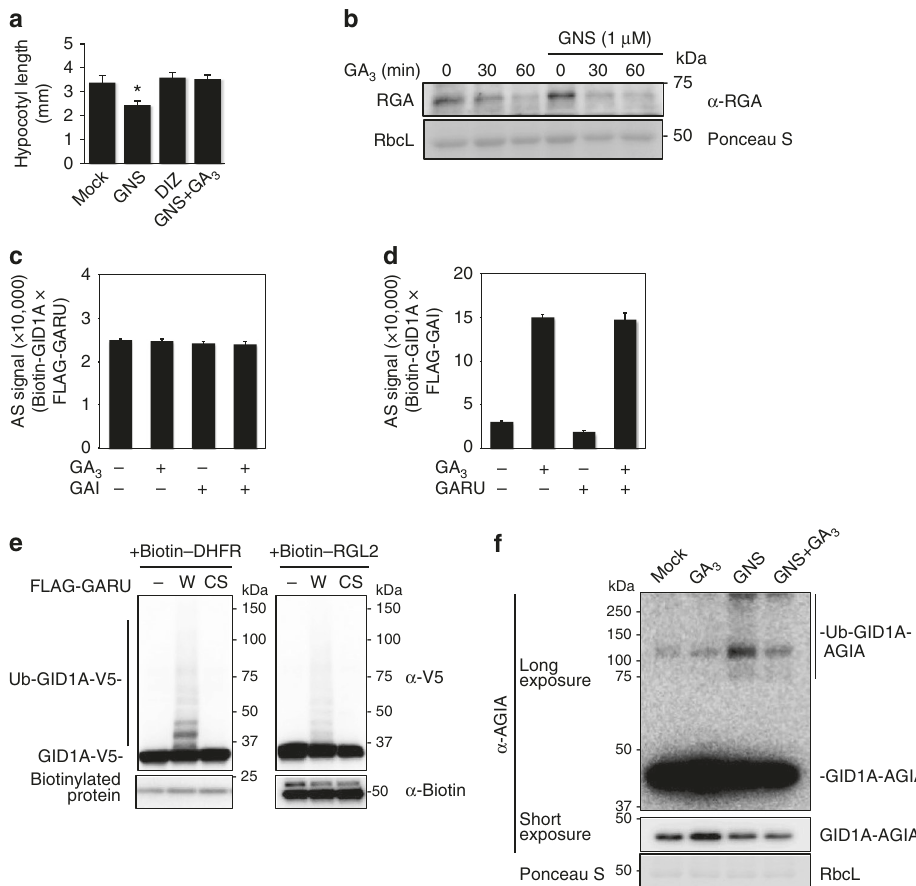
Fig. 5 GA blocks GARU-dependent GID1A ubiquitination. a Hypocotyl elongation assay of etiolated seedlings in response to 10 µ M GNS, 10 µ M daidzein (DIZ), and 10 µ M GNS with 5 µ M GA 3 (GNS + GA 3 ). Error bars indicate ± s.d. of three replicates, n = 21. Statistically signi fi cant changes compared with Mock are indicated ( *P < 0.05, as determined using two-tailed Student ’ s t -test). b GA-induced RGA degradation assay in Col-0 seedlings that were pretreated without or with 1 µ M GNS for 6 h. Seedlings were treated with 5 µ M GA 3 at indicated times. c AlphaScreen analysis of biotin – GID1A – FLAG – GARU interaction in the presence (+) or absence ( − ) of 1 µ M GA 3 and V5-GAI. Data are means ( ± s.d.) of three independent experiments ( n = 3). d AlphaScreen analysis of biotin – GID1A – FLAG – GAI interaction in the presence (+) or absence ( − ) of 1 µ M GA 3 and V5-GARU. Data are means ( ± s.d.) of three independent experiments ( n = 3). e In vitro ubiquitination assay of GID1A. GID1A-V5 was incubated with FLAG-GARU WT (W) or GARU C190/193S (CS) in the presence of 1 µ M GA 3 , and biotin-DHFR or biotin-RGL2. Ubiquitinated GID1A (Ub-V5-GID1A) and unubiquitinated GID1A (V5-GID1A) were detected by anti-V5 antibody. f Immunoblot analysis of GID1A-AGIA. GID1A-AGIA was transfected into protoplasts. After incubation with 10 µ M GA 3 and/or 5 µ M GNS for 6 h, GID1A-AGIA and ubiquitinated (Ub) GID1A-AGIA proteins were analyzed by anti-AGIA